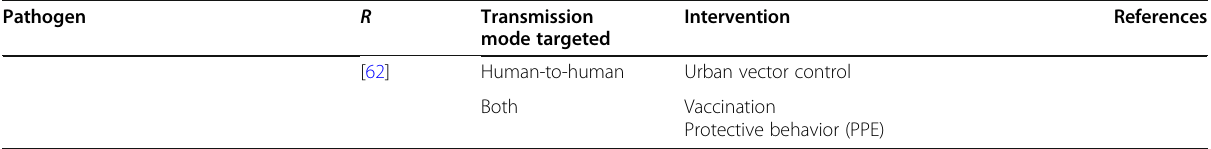
Table 1 A collection of systems which have implemented control measures targeted at spillover animal-to-human transmission, human-to-human transmission, or both and their associated reproductive numbers (Continued) Pathogen R